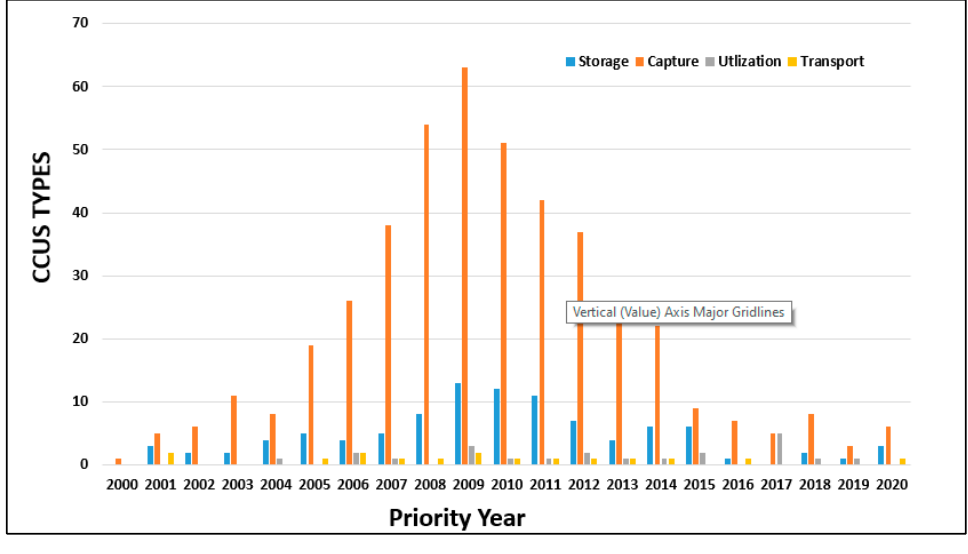
Figure 11. CCUS types—countries (Level 1 category).